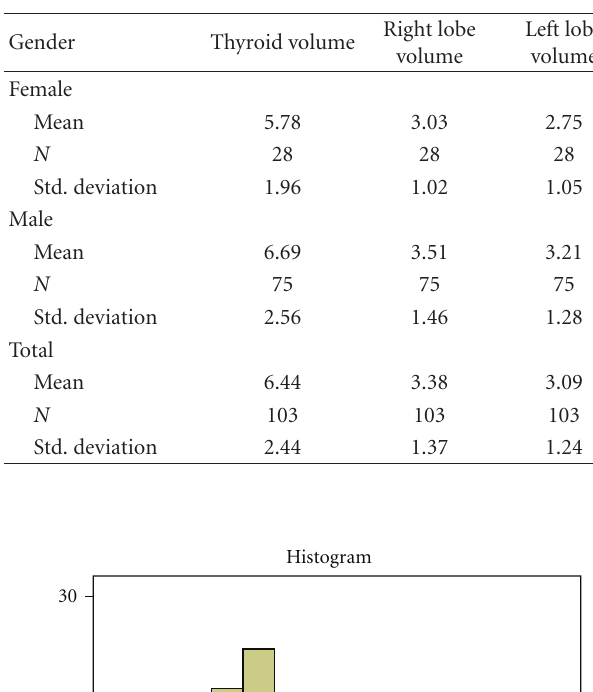
Table 1: Volume of the thyroid